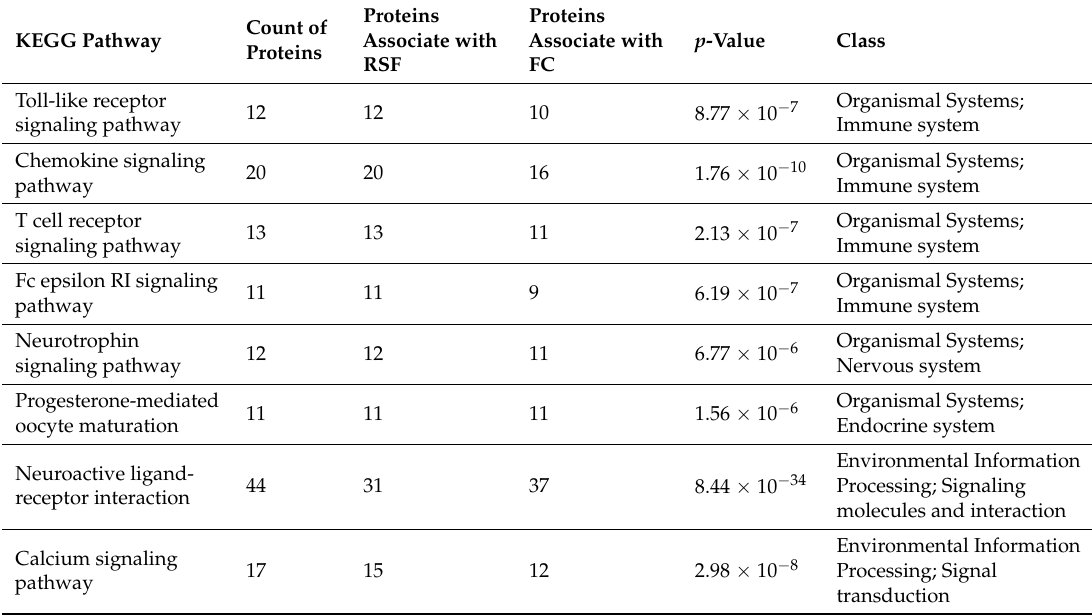
Table 2. The top 20 KEGG pathways of 95 putative targets with Benjamini Hochberg corrected p -values < 0.05 generated by